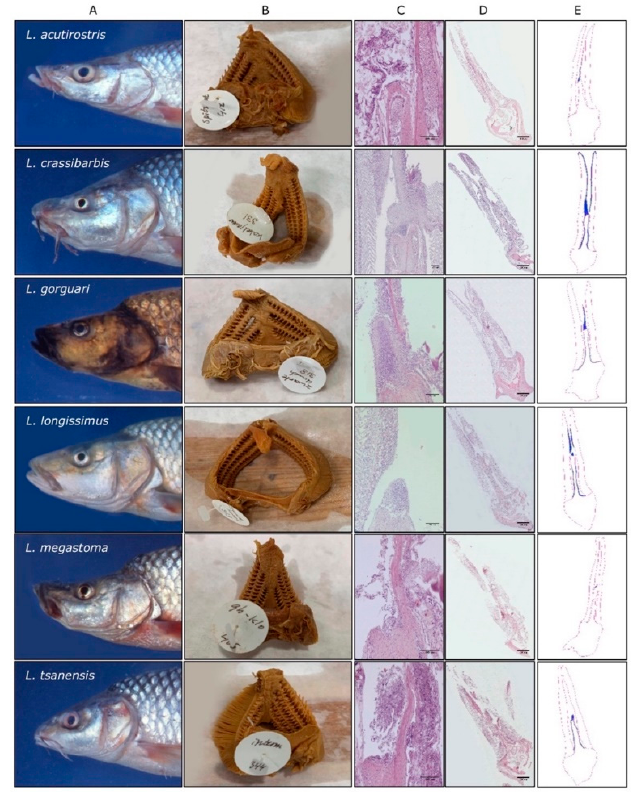
Figure 8. Heads of 6 endemic Labeobarbus species flock in Lake Tana (column ( A )) and their isolated gills (column ( B )) after 24-h fixation in formalin and followed by 26-year storage in 70% alcohol [24], and a transverse view of lymphoid tissue (ILT) in HE-stained gills (Scale bar is 100 μ m, column ( C )), transverse view of HE-stained gills (Scale bar is 500 µ m, column ( D )), transverse drawing of gill morphology (column ( E )). The transverse drawings of gill morphology are based on scanned HE-stained gills, and lymphocyte-like cell accumulations are in blue (column ( E )).